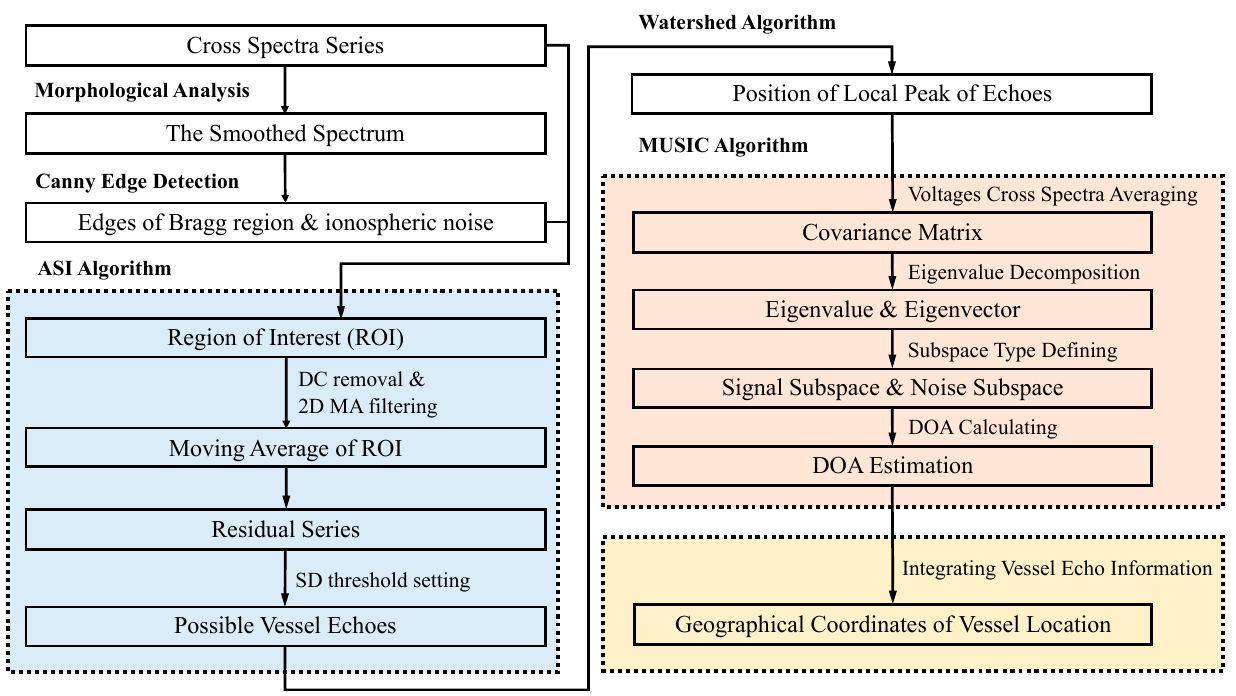
Figure 4. The proposed data processing procedure for SeaSonde HF radar to detect the geographic coordinates of vessels includes echo identification, locating the peaks of echo signals, and ship direction detection.